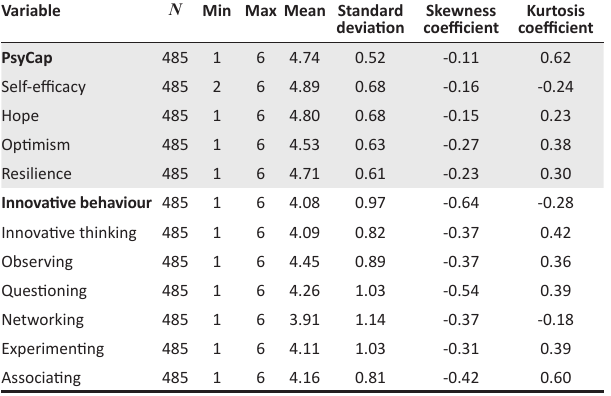
TABLE 2: Descriptive statistics, skewness and kurtosis coefficients. Variable